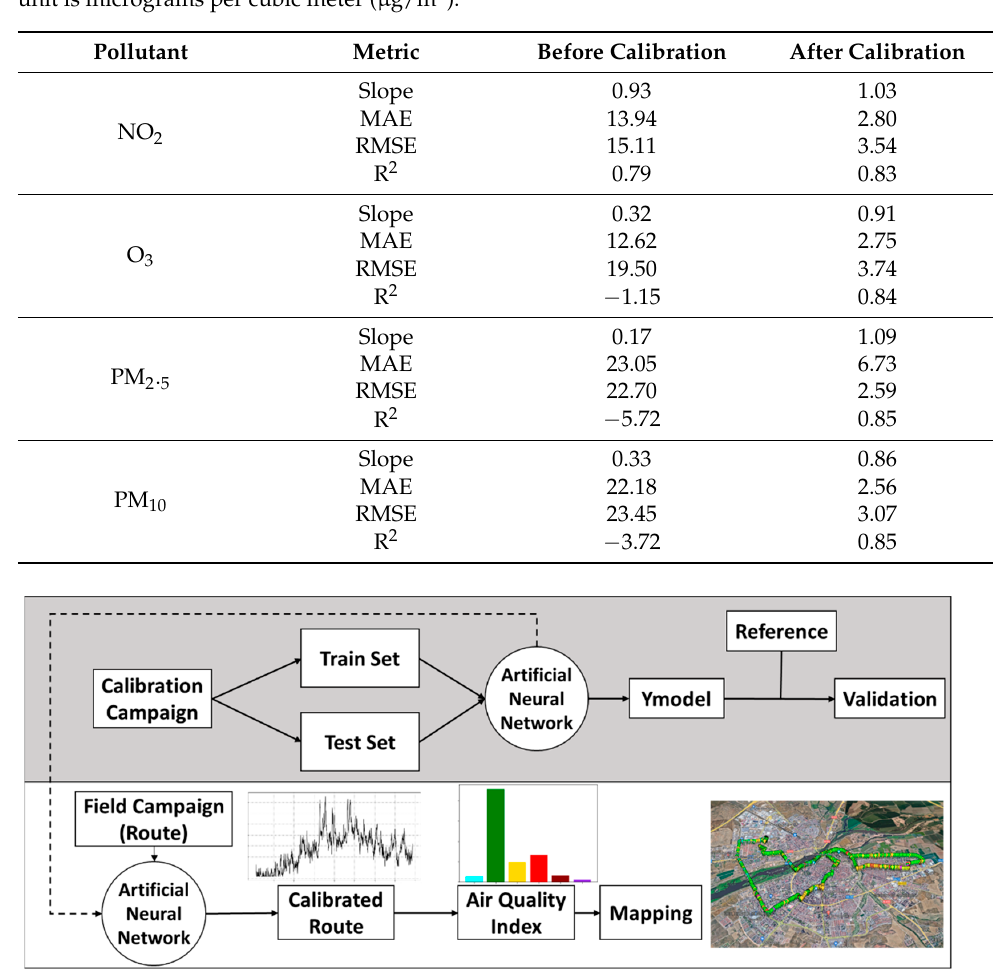
Table 1. Metrics of artificial neural network performance as a calibration algorithm. Measurement unit is micrograms per cubic meter ( μ g/m 3 ).